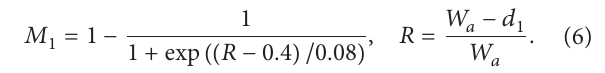
behavior to walk along the left-hand (right-hand) side. The subconscious strength 𝑀 is introduced to show the effect of guide sign. The subconscious strength 𝑀 is calculated as follows: